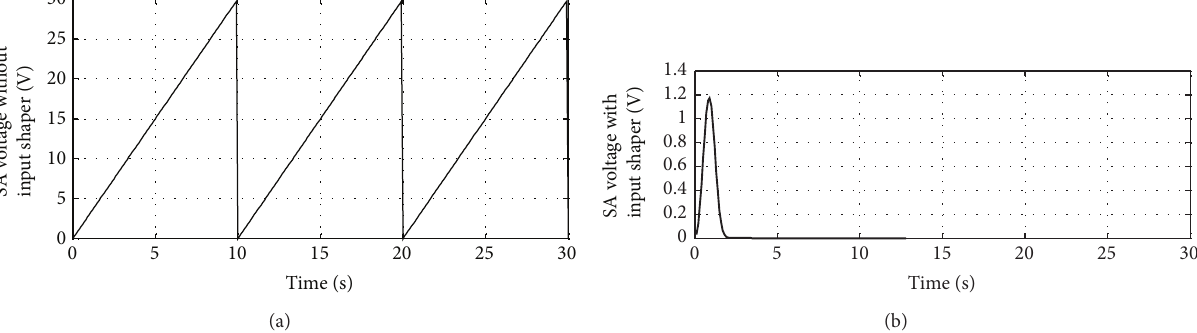
Figure 10: Case 1: SA voltage (a) without and (b) with input shaper.